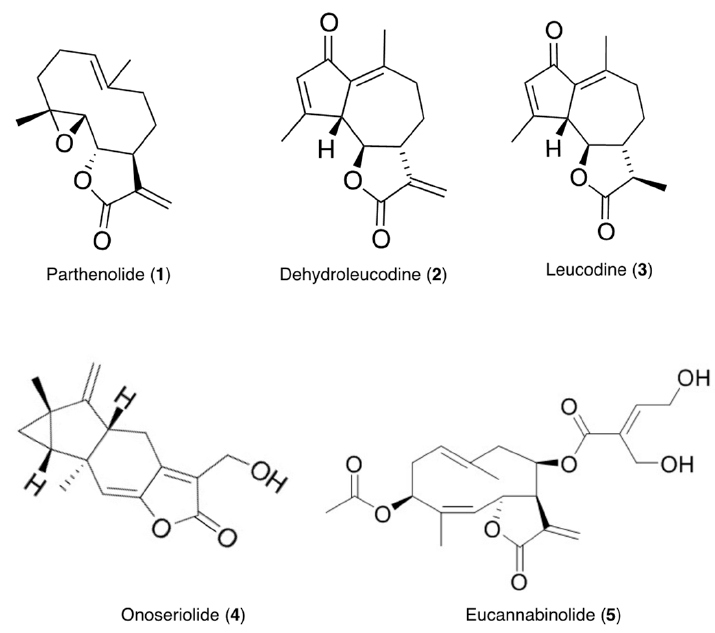
Figure 1. Structures of compounds isolated from the tested plants.